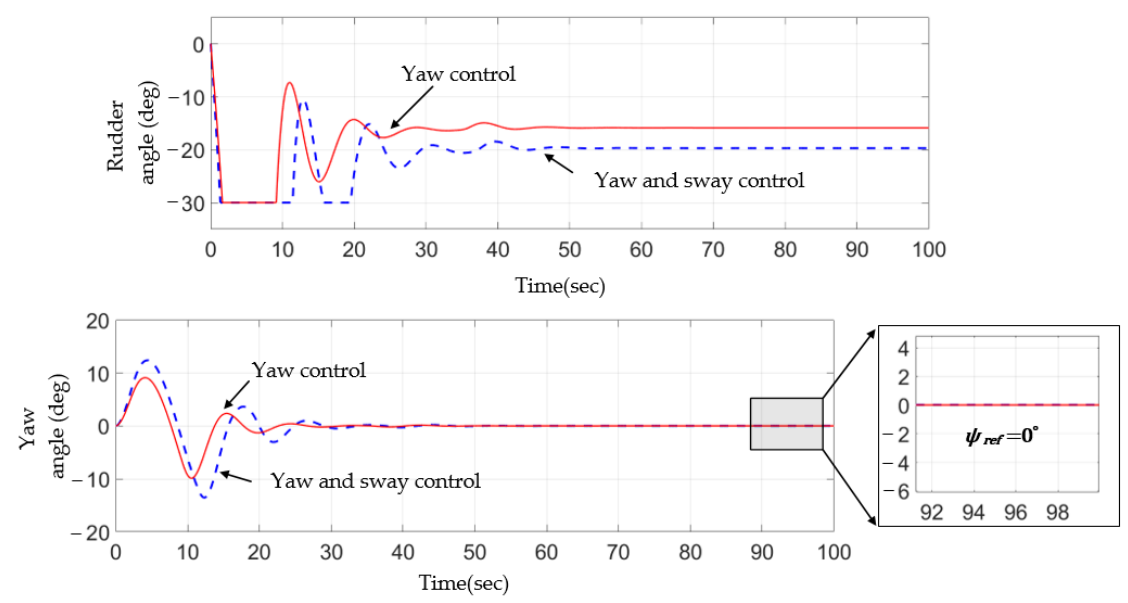
Figure 16. Simulation results with only yaw control and yaw and sway control at point marked with a circle.